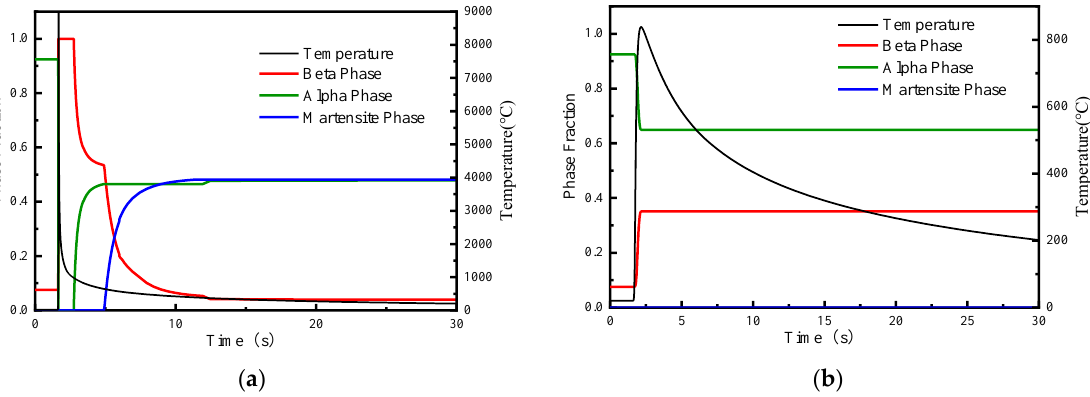
Figure 22. Change of phase volume fraction in weld area of LBW weldment: ( a ) FZ zone, ( b ) PM/HAZ interface.